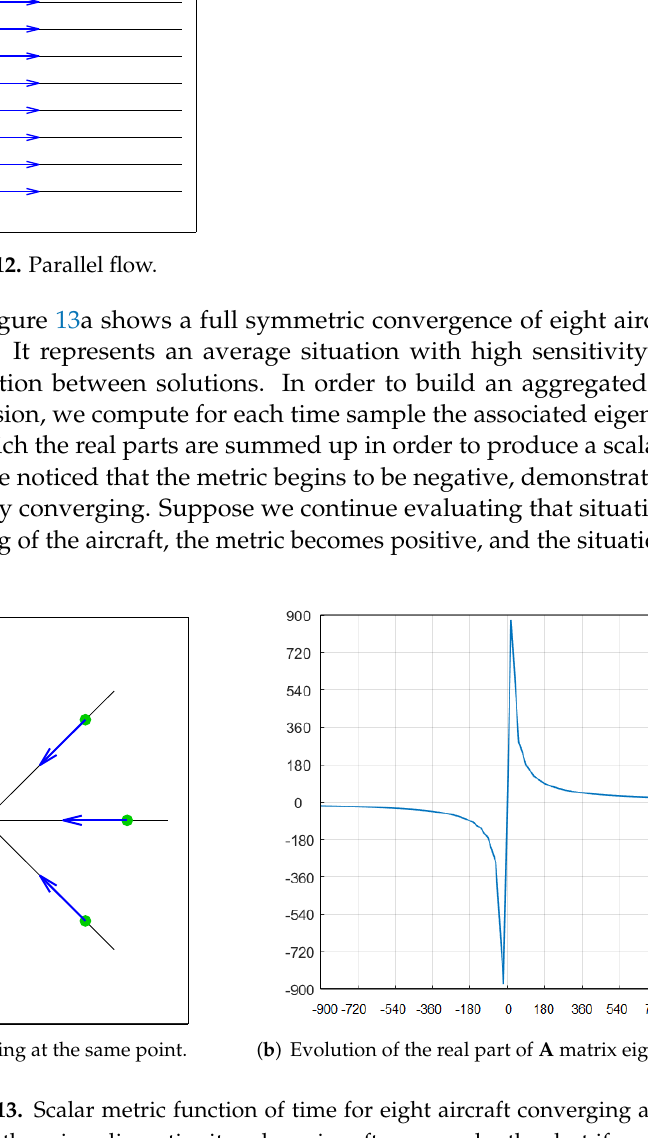
Figure 13. Scalar metric function of time for eight aircraft converging at the same point. As it is shown, there is a discontinuity when aircraft cross each other but if we consider more aircraft in the crossing, the curve will be scaled accordingly (more aircraft will induce larger negative and positive